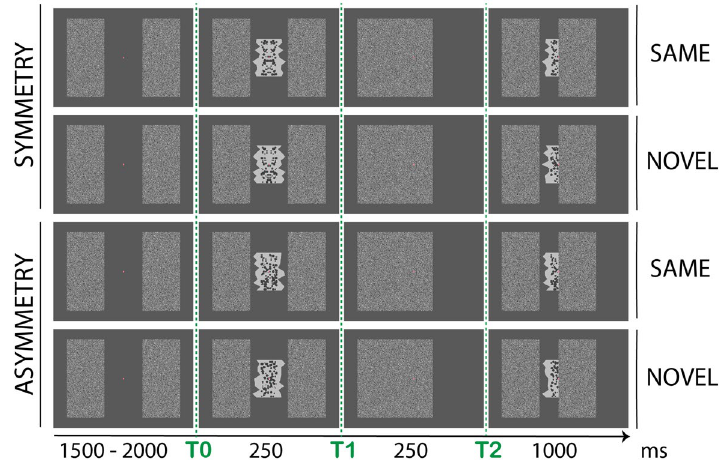
Figure 2. Experiment 1. Example of stimuli and experimental procedure. A fully-visible abstract shape, either symmetric or asymmetric, was shown for 250 ms flanked by two large rectangles (t0). One of the rectangles (the right on in the figure) moved towards the center to cover the shape. The occluder then moved back (towards the right) to reveal half of the shape underneath (t2). The now partly-visible shape may be the Same as previously seen or a Novel (different) shape. The four possible conditions (from top to bottom) are: SymmetrySame , shape in t0 is symmetric and shape in t2 is the same (but half-occluded); SymmetryNovel , shape in t0 is symmetric and shape in t2 is different (novel); AsymmetrySame , shape in t0 is asymmetric and shape in t2 is the same; AsymmetryNovel , shape in t0 is asymmetric and shape in t2 is different. For simplicity, the figure illustrates only displacement of the right-occluder. The same combinations were obtained for the left-occluder (counterbalanced across